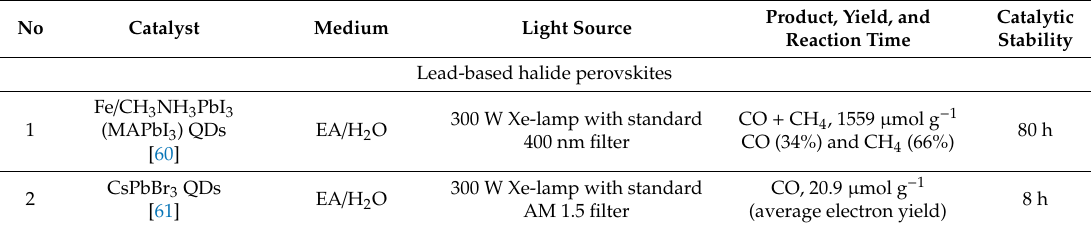
Table 2. The progress of Pb and Pb-free perovskites for CO 2 reduction with details including catalysts [reference], reaction medium, light source, product yield and time, and stability (*EA = ethyl